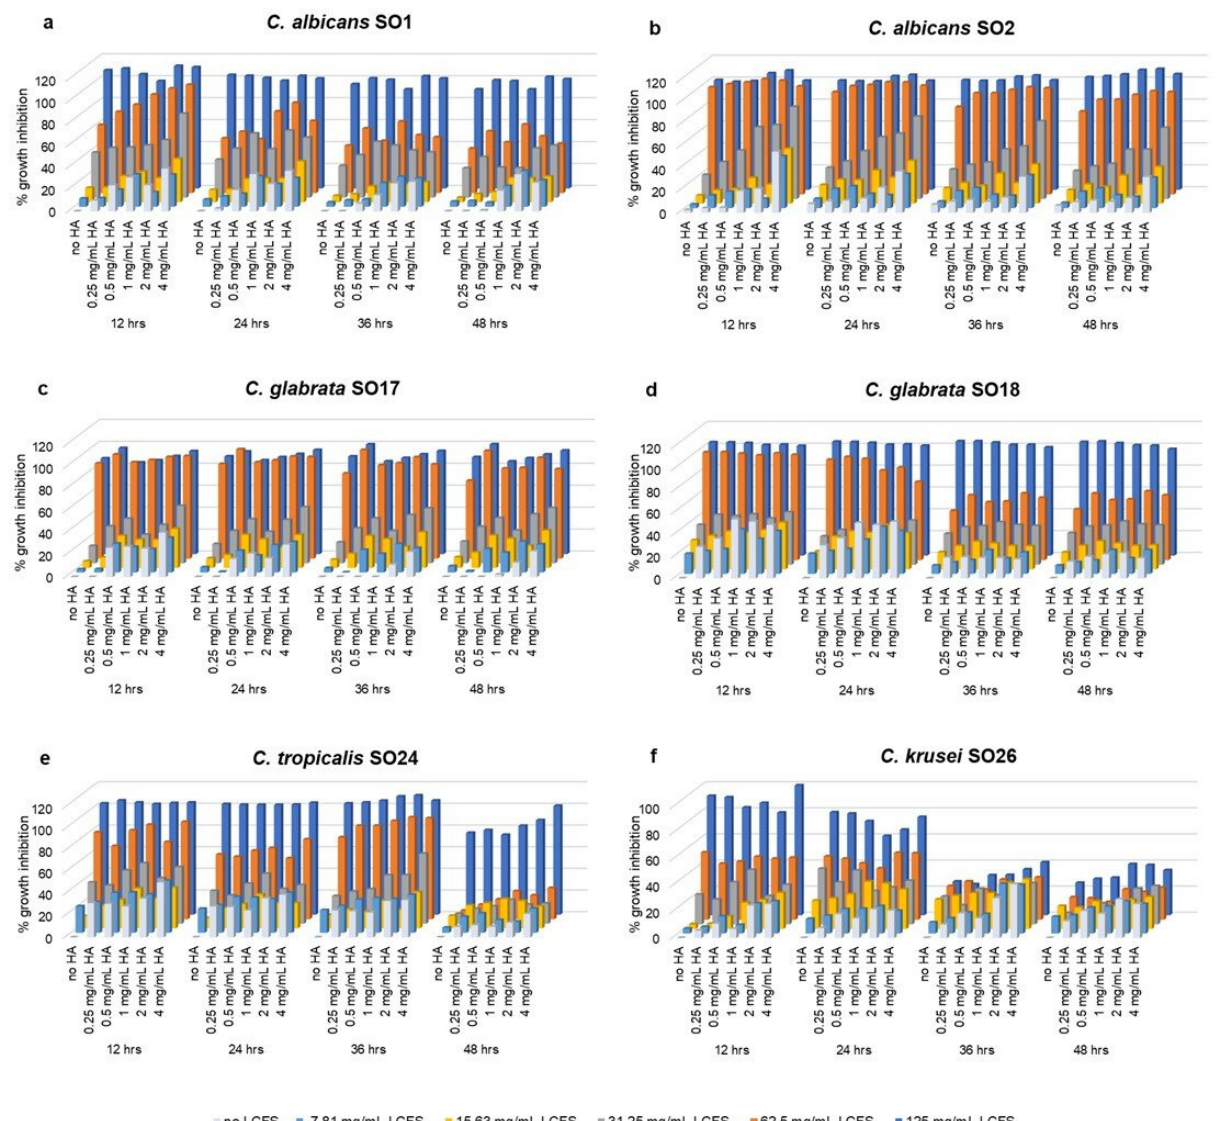
Figure 2. Growth inhibition (%) of ( a ) C. albicans SO1, ( b ) C. albicans SO2, ( c ) C. glabrata SO17, ( d ) C. glabrata SO18, ( e ) C. tropicalis SO24, and ( f ) C. krusei SO26 in the presence of different combinations of LCFS (7.81–125 mg/mL) and HA (0.25–4 mg/mL) over time.